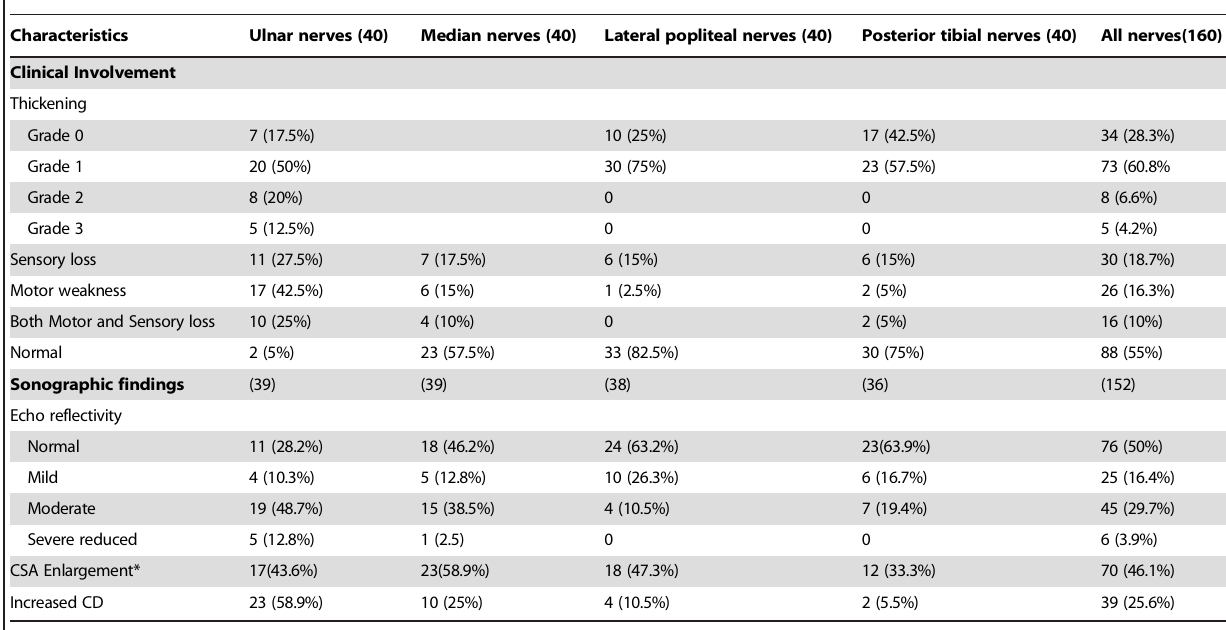
Table 3. Clinical and sonographic findings of major peripheral nerves of upper and lower limbs in 20 leprosy patients.